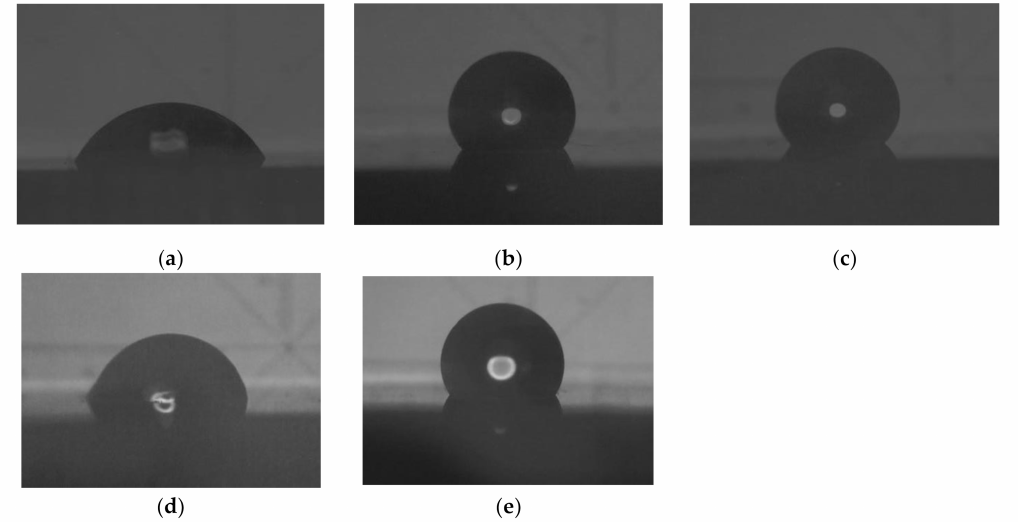
Figure 3. Images of the water drop on each PMMA specimen: ( a ) Control; ( b ) Ar; ( c ) Ar / F; ( d ) Ar + Ag; ( e ) Ar / F + Ag